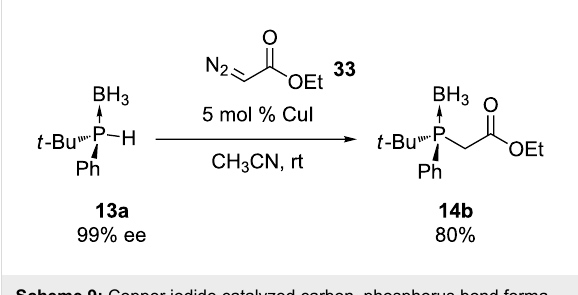
Scheme 9: Copper iodide catalyzed carbon–phosphorus bond forma-